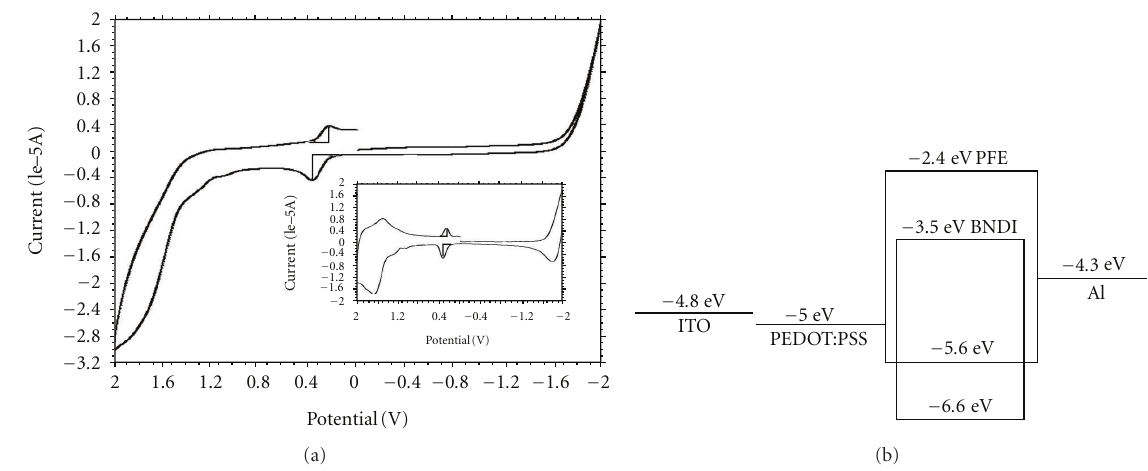
Figure 2: (a) Cyclic voltammogram of PFE in chloroform ( inset : derivative of cyclic voltammogram) and (b) energy level diagram of the photodetector.